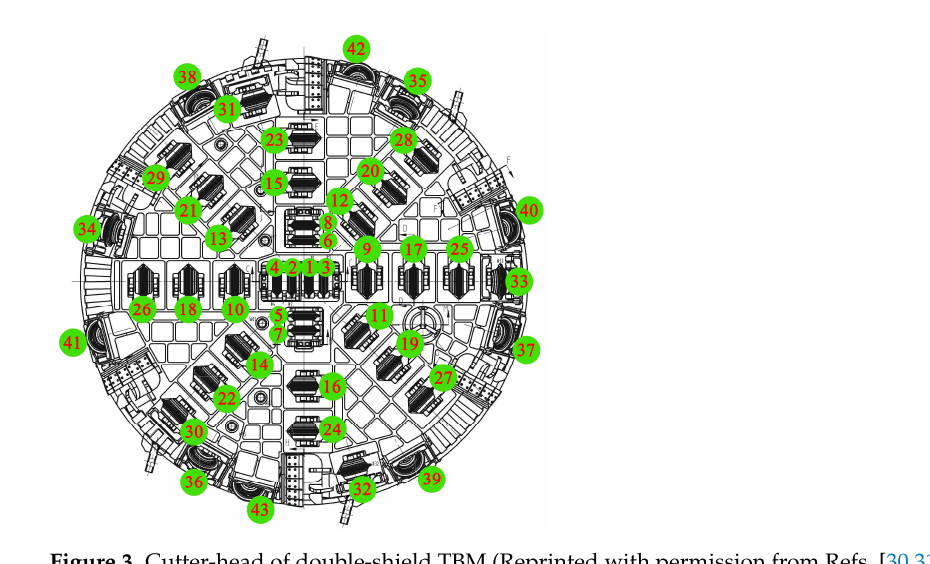
Figure 3. Cutter-head of double-shield TBM (Reprinted with permission from Refs. [30,31].)